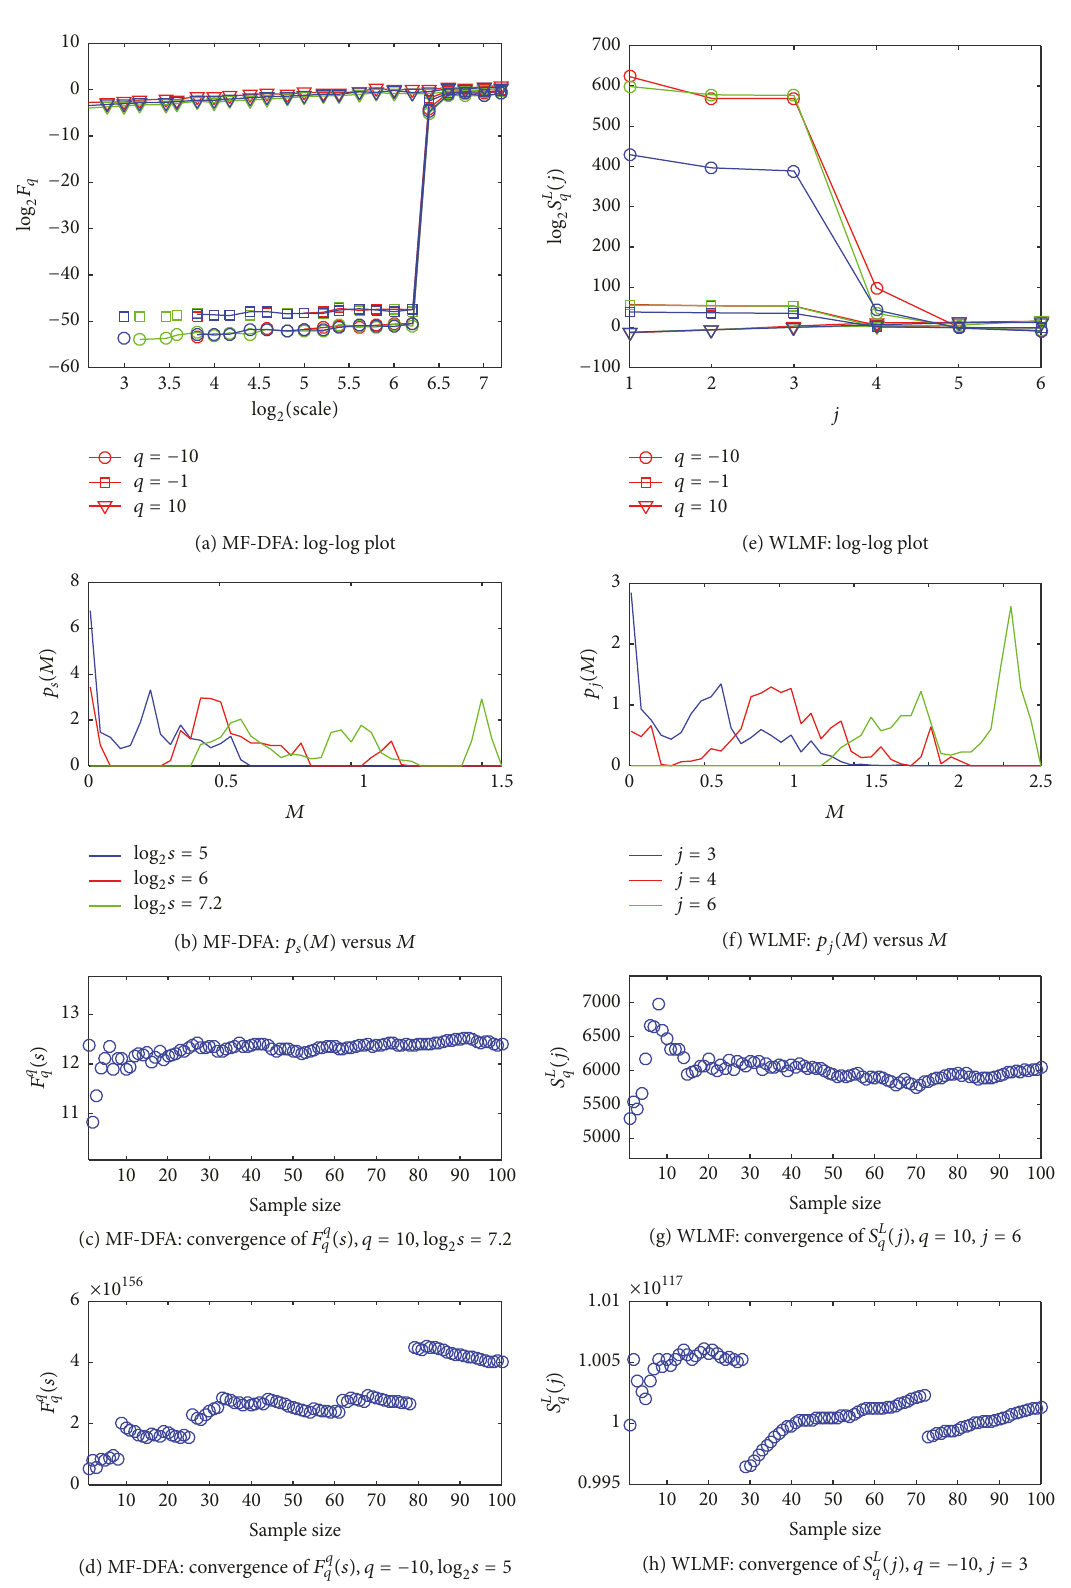
Figure 6: Statistical tests at Site 7. (a) and (e) show the log-log plots of MF-DFA and WLMF; different colors indicate different orders of polynomial (ordifferentvanishing momentsofwavelet). (a)2-order(red),3-order(blue), and4-order(green). (e)2-moment(red),3-moment (blue), and 4-moment (green). (b) shows the pdf of (𝐹 2 ( V ,𝑠)) 1/2 . (c) and (d) show the convergence of 𝐹 𝑞 𝑞 (𝑠) . The results in (b), (c), and (d) are based on 3-order. (f) shows the pdf of 𝐿 𝑋 (𝑗,𝑘) . (g) and (h) show the convergence of 𝑆 𝐿 𝑞 (𝑗) . The results in (f), (g), and (h) are based on 3-moment. These results correspond to an averaging over 100 sets of daily